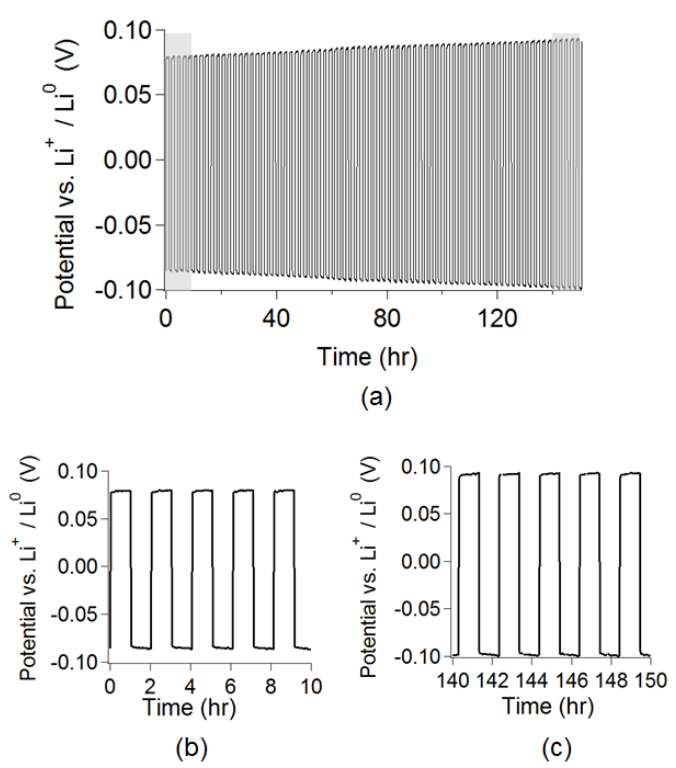
Figure 5. Galvanostatic cycling of a Li/PEG 31 DA-x-PEG 14 MA-x-STFSILi/Li coin cell at 50 µ A/cm 2 at 70 °C: ( a ) time period of 0 to 150 h, with shaded areas displayed on a larger scale in ( b , c ).